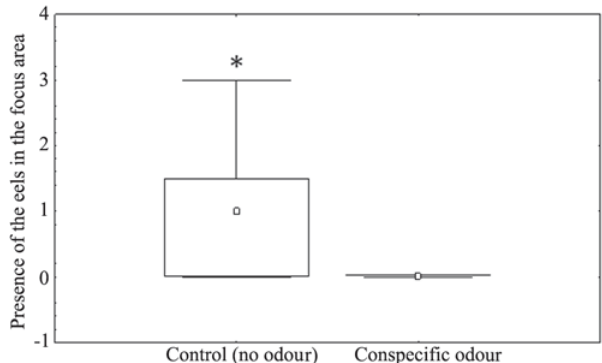
Fig. 3. The effects of conspecific odour on spatial choice in the speckled worm eel Myrophis punctatus . Data are shown as median (small square), minimum and maximum obtained value (lines) and quartiles 25-75% (boxes). In this analysis, presence of eels on the randomly chosen focus area was compared by Mann-Whitney U test and * indicates statistical difference (p <